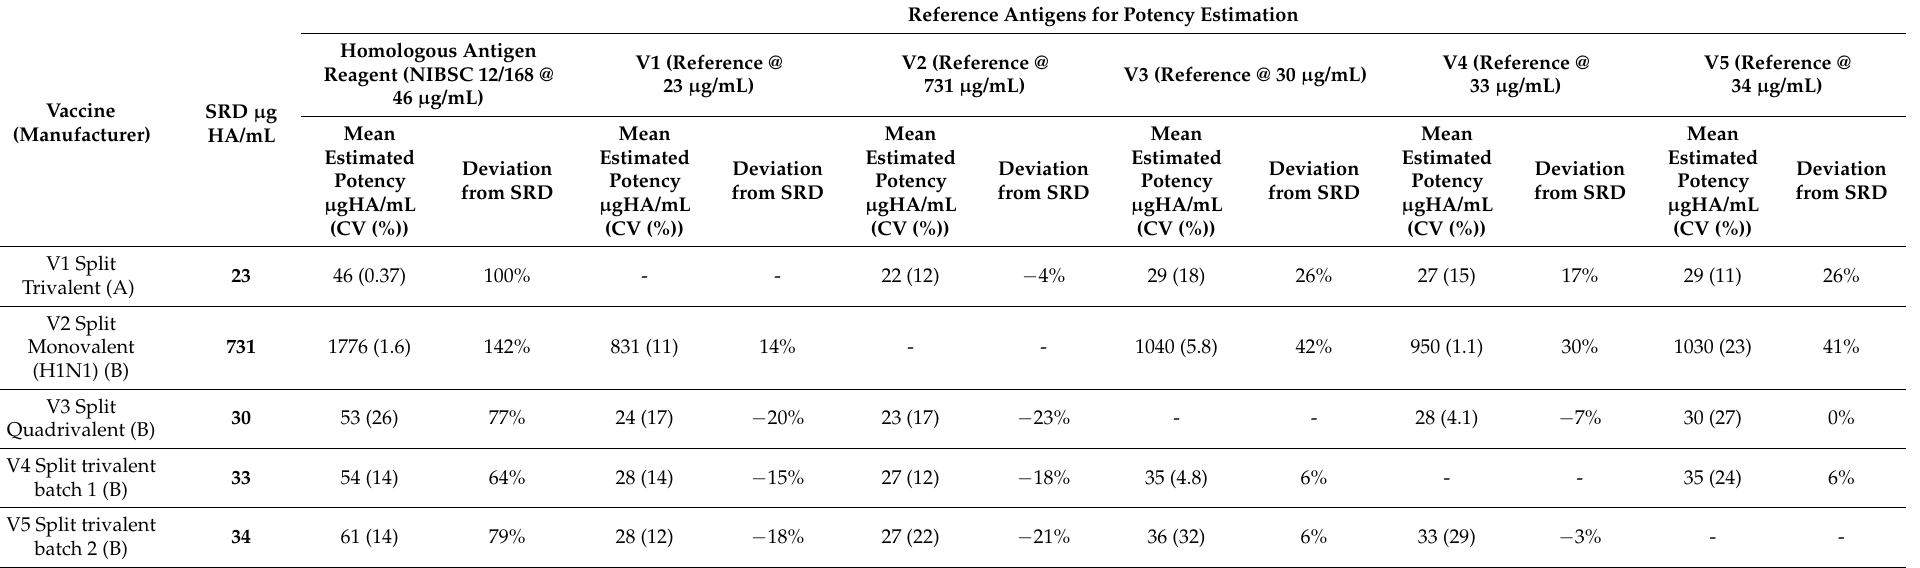
Table 3. Potency estimates of vaccine samples by competitive